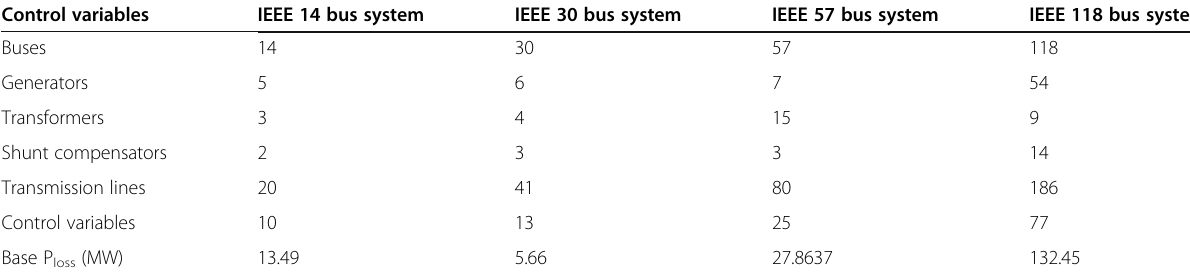
Table 2 Typical parameters of the bus systems Control